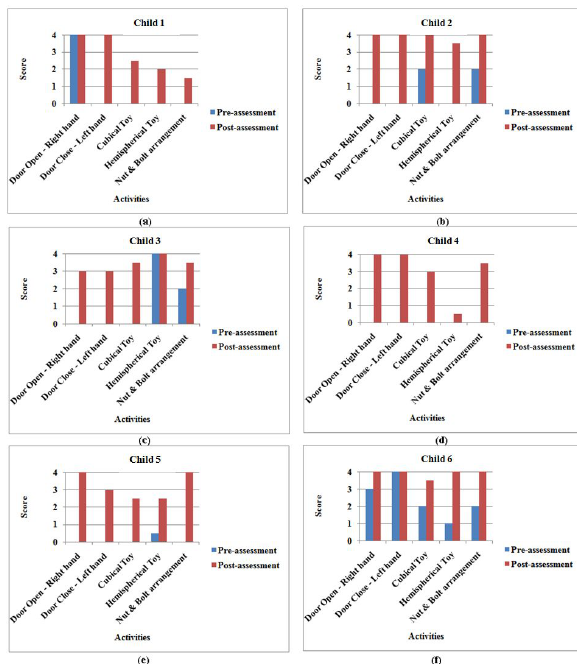
Figure 6: Pre-assessment and post-assessment comparison